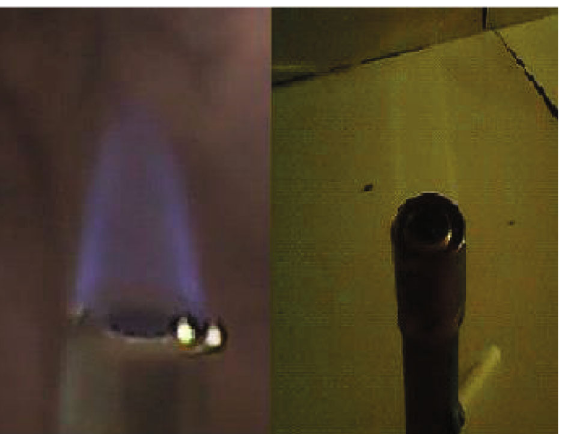
Figure 5: Flame of burned